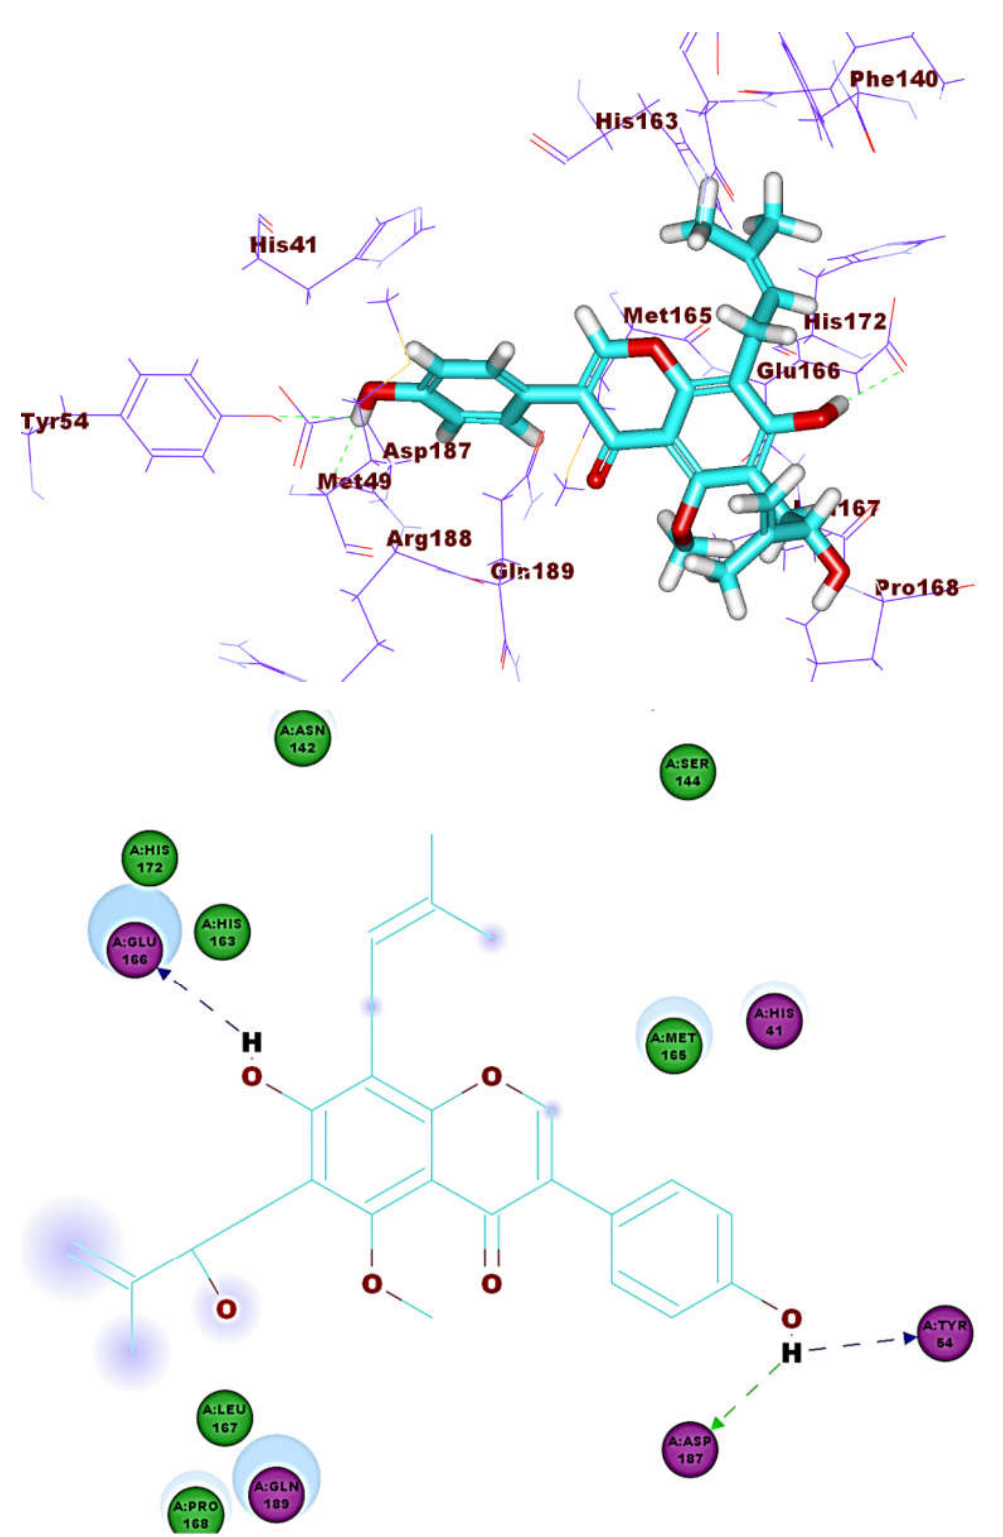
Figure 13. Compound 30 docked into M pro , forming three H. bonds with Glu166, Cys145 and His163.